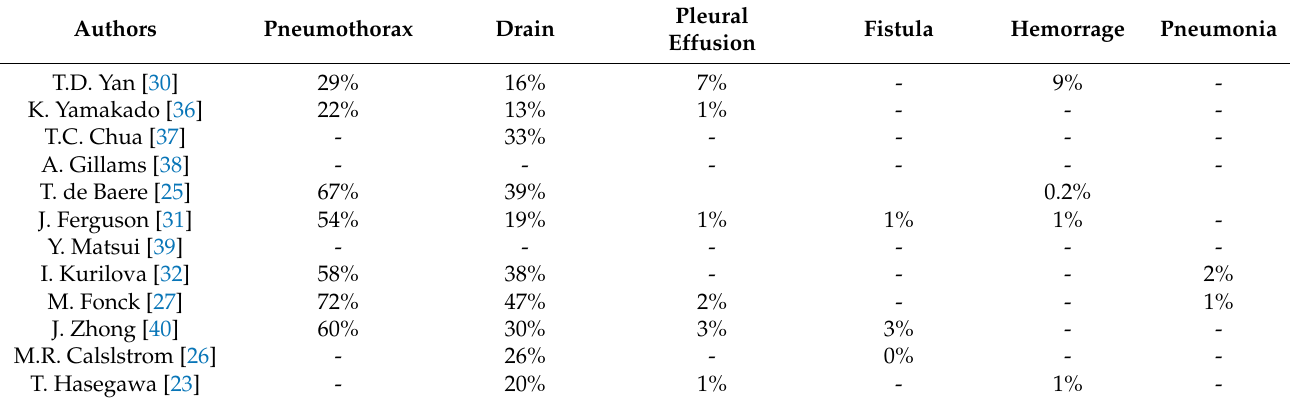
Table 2. Adverse events after lung thermal ablation in the 12 previously analyzed